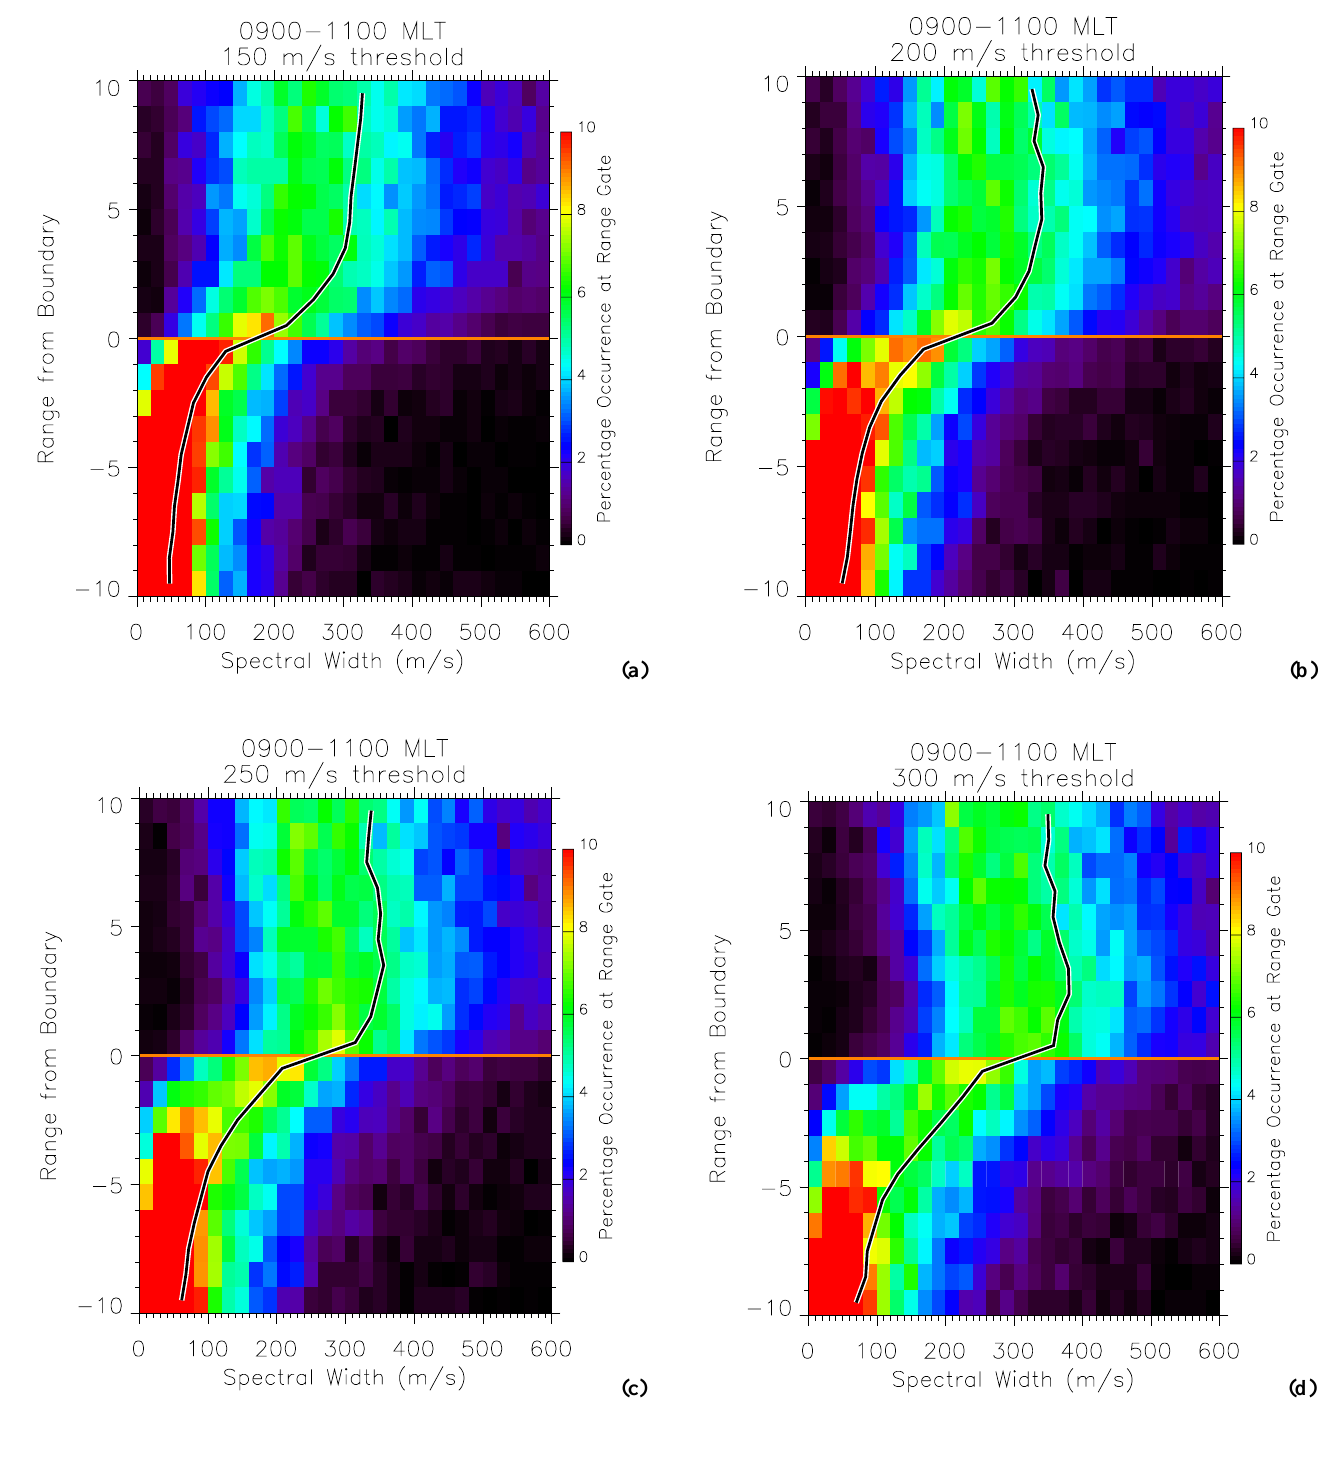
Fig. 7. The distribution of spectral width values ordered by range from the spectral width boundary, determined by applying the C-F threshold technique to 5-years worth of spectral width data from beam 8 of the Halley SuperDARN radar. Only data from the 09:00–11:00 MLT region are shown. The results are presented for four different spectral width threshold values, (a) 150m/s, (b) 200m/s, (c) 250m/s, and (d) 300m/s. The horizontal orange line represents the boundary location. The black on white lines represent the variations of the medians of the distributions with range from the